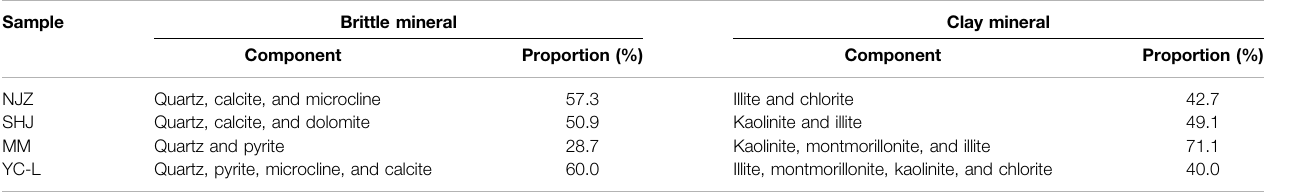
TABLE 5 | Main mineral contents of four shale